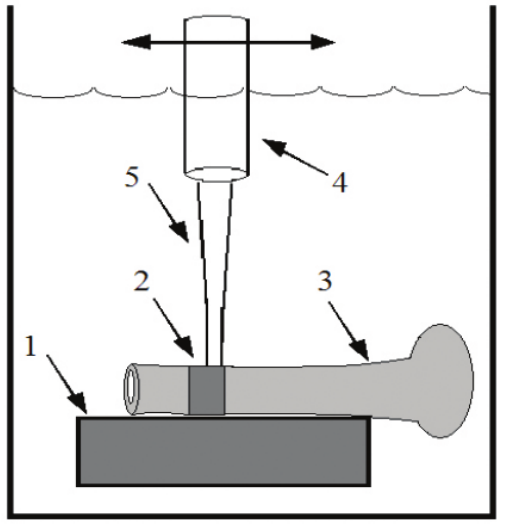
FIGURE 3 - Experimental apparatus: (1) reflector; (2) pseudarthrosis; (3) diaphysis; (4) transducer